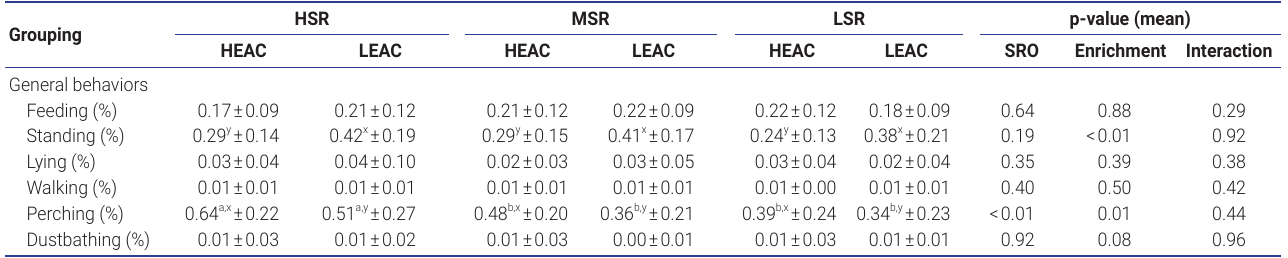
Table 6. Effects of social ranking order on general state behaviors in high or low perch and dust-bath allocation (mean±standard deviation)